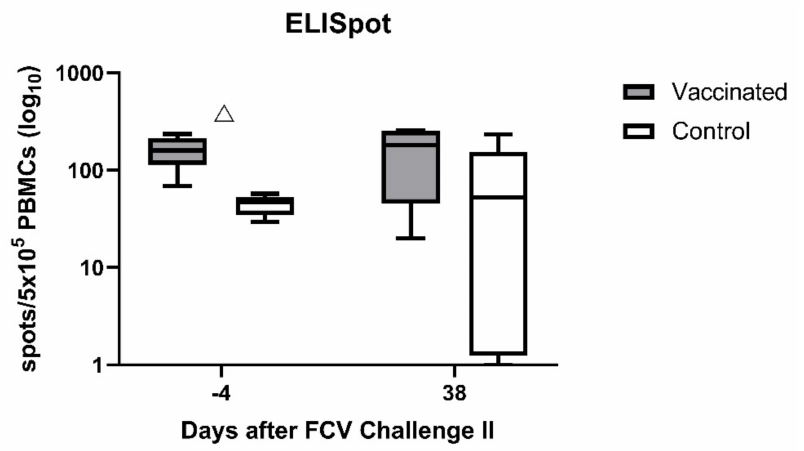
Figure 17. Box and whisker plots of IFN- γ -releasing PBMCs after stimulation with the challenge virus FCV 27. The line inside the box shows the median, and the lower and upper border of the box indicates the 25th and 75th percentile, respectively. Whiskers represent minimum and maximum values. Significant differences between the vaccinated and the control group are indicated with an open triangle; (cid:52) denotes significantly higher in the vaccinated group P MWU ≤